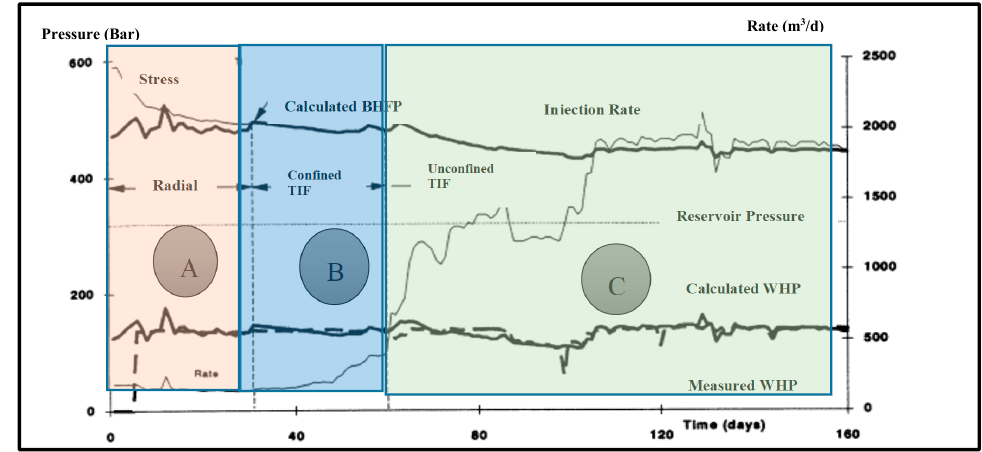
Figure 8. Final history match assuming an unconfined TIF after 60 days for well A [5].